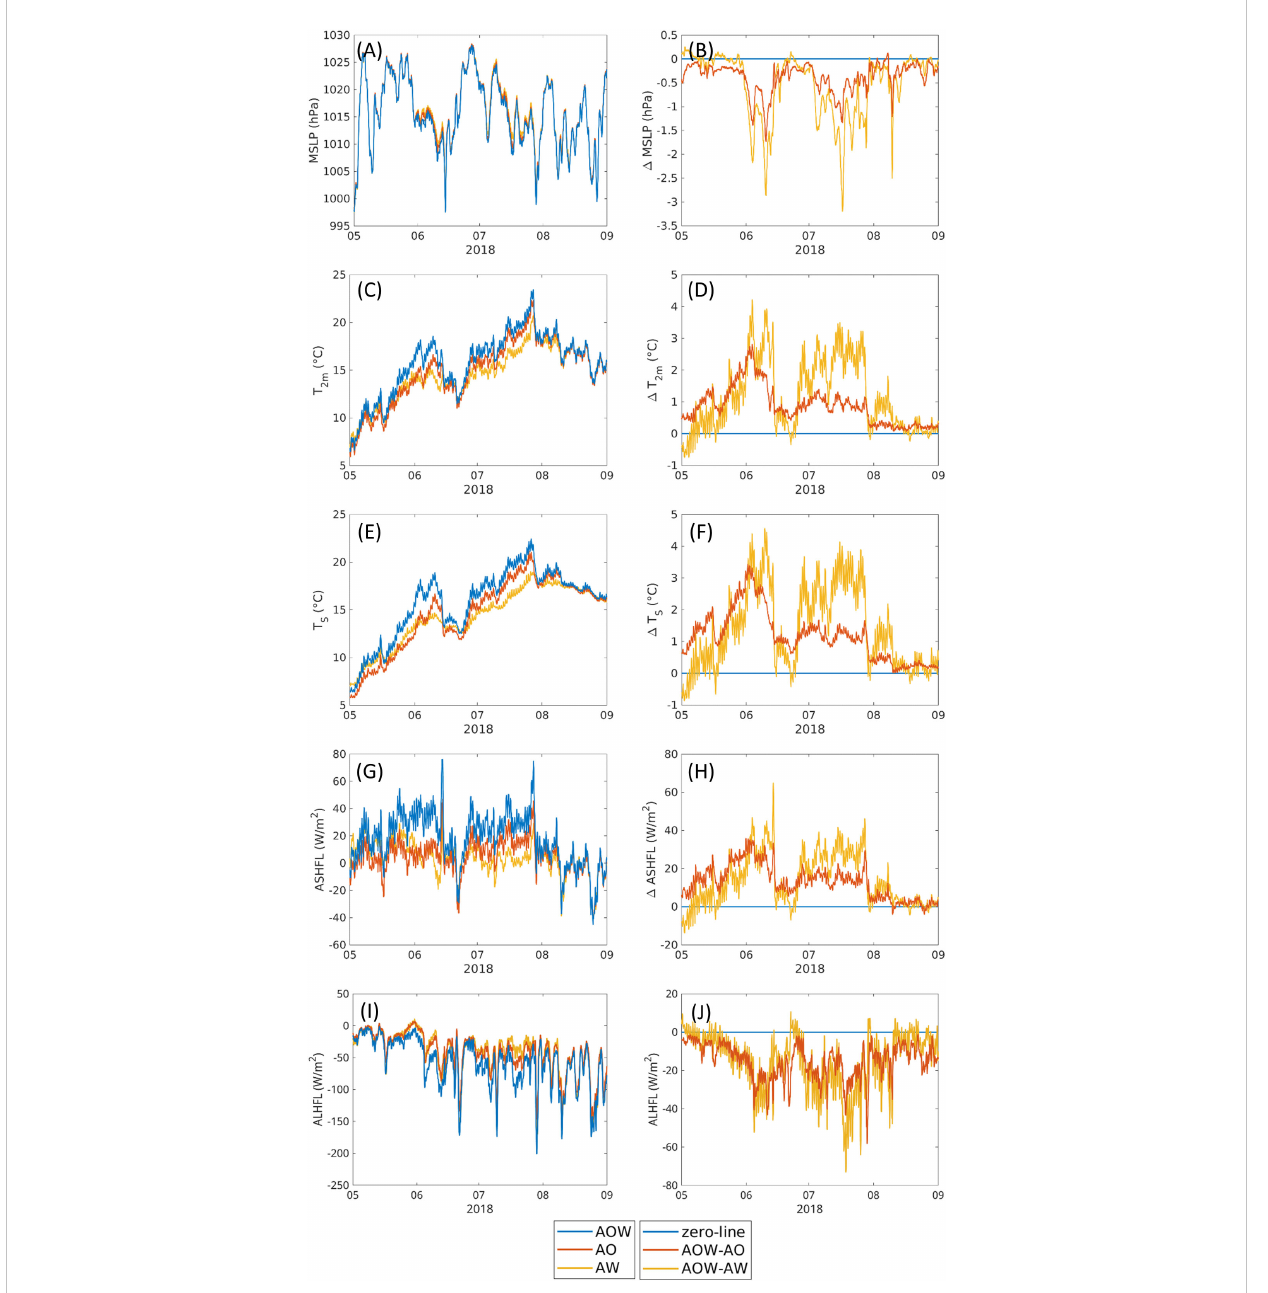
FIGURE 8 Time series of hourly values (left side) as well as differences with respect to AOW, which is represented by the zero line, (right side) of MSLP (A, B) , 2- m air temperature (C, D) , surface temperature (E, F) , sensible heat fl ux (G, H) , and latent heat fl ux (I, J) in the North Sea for summer 2018. Sensible and latent heat fl uxes are positive downward. The time series represent equally weighted